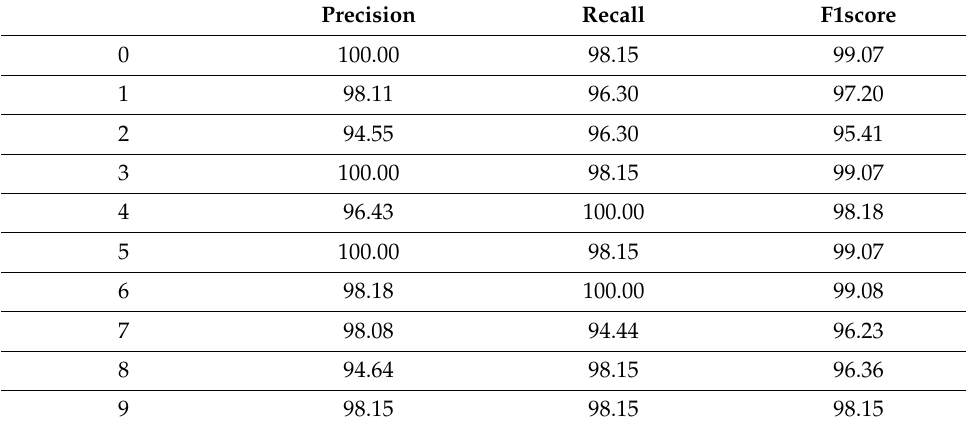
Table 2. Accuracies of the proposed method over characters.